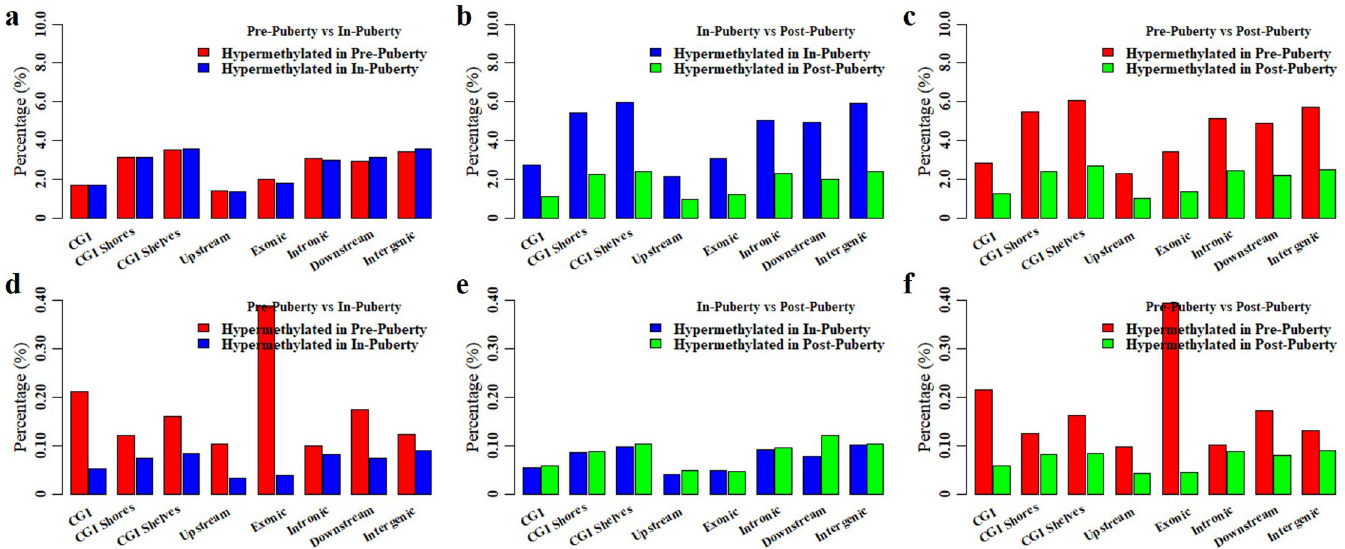
Fig 6. Differentially methylated CpGs and CpHs among these pituitaries. Distributions of differentially methylated CpGs between Pre- and In- ( a ), In- and Post- ( b ), and Pre- and Post-pubertal methylome ( c ). Distributions of differentially methylated CpHs between Pre- vs In- ( d ), In- vs Post- ( e ), and Pre- vs Post-pubertal stage ( f ).